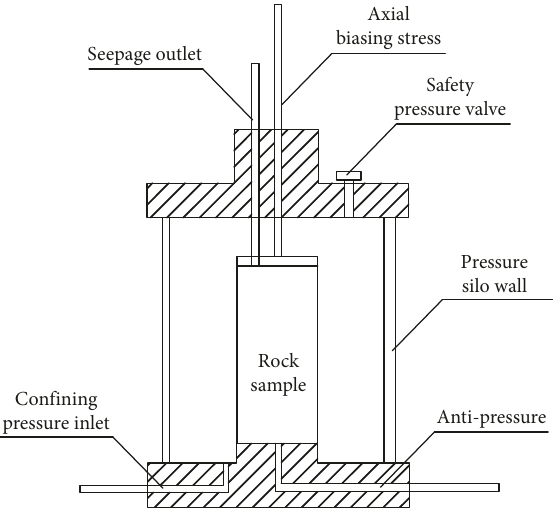
Figure 6: Schematic diagram of measurement